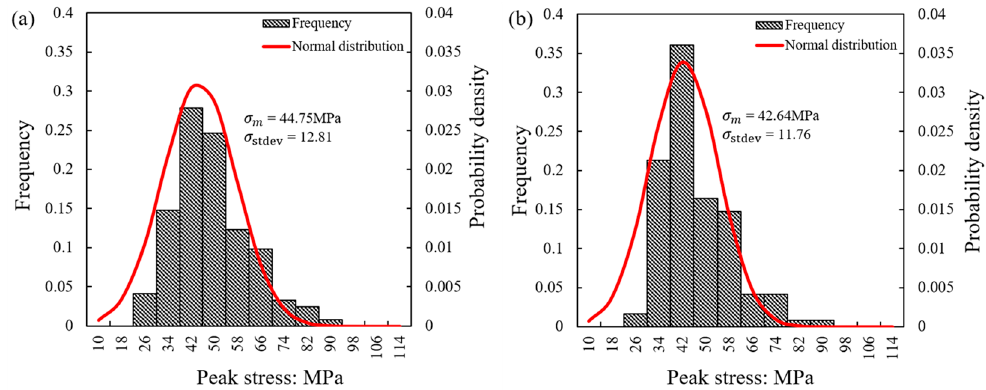
Figure 6. Frequency distribution of peak stress for different loading rates: ( a ) 0.01 mm/min; ( b ) 1 mm/min.